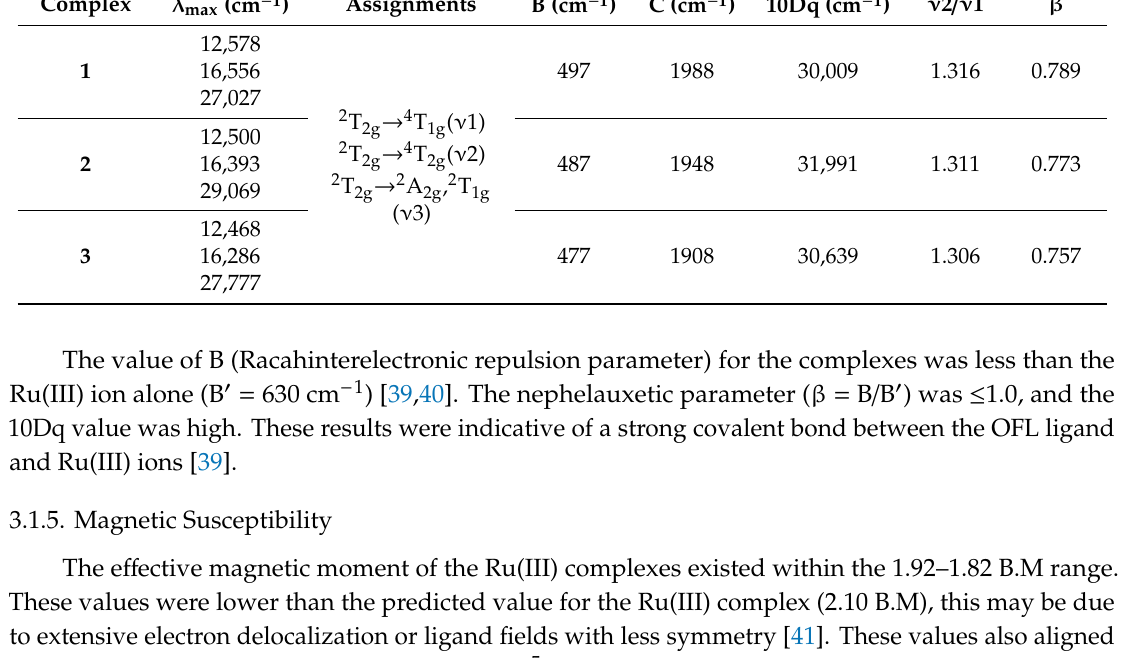
Table 2. Ligand field and interelectronic repulsion parameters of the synthesized complexes.